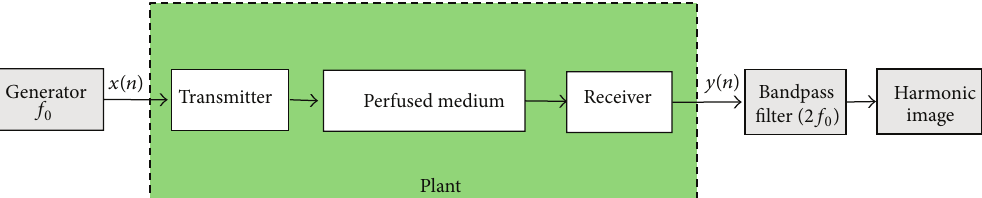
Figure 1: Block diagram of second harmonic imaging.